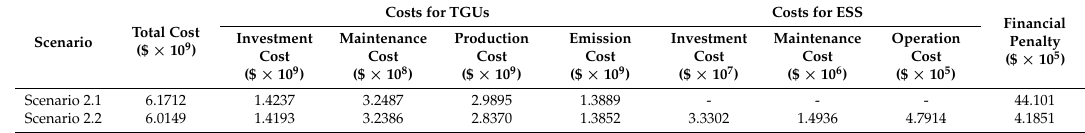
Table 7. Costs regarding the effect of an ESS.